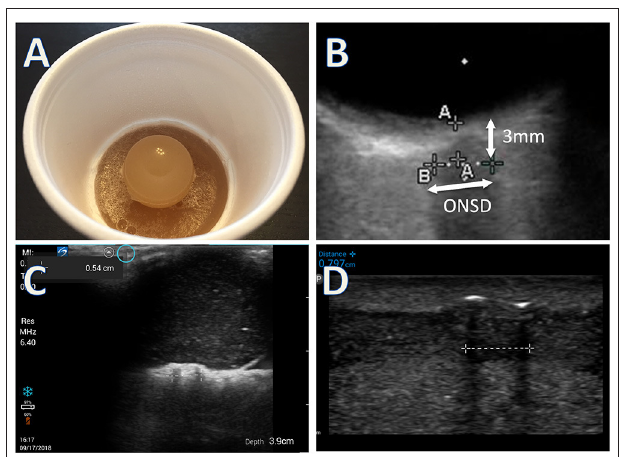
FIGURE 1 | (A) Simulation model made with a short segment of intravenous or nasogastric tube suspended in gelatin, under a gelatin eyeball. (B) Image of simulation model obtained from Onsite M-turbo (standard sized portable ultrasound) zoomed in with superimposed arrows to highlight measurement technique. (C) Image of simulation model from Sonosite IVIZ (pocket ultrasound) device. (D) Image of simulation model from Philips Lumify (pocket ultrasound) device. All measurements performed at 3mm behind the simulated orbit. Calipers used to measure distance behind the globe not shown in (C,D)